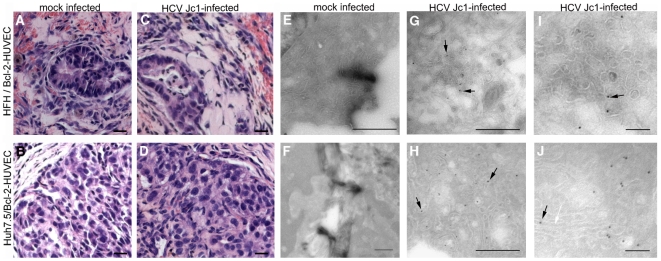
Histological and IEM analysis of HCV Jc1-infected HFH and Huh-7.5.Large numbers of epithelial-appearing cells were observed in Bcl-2-HUVEC gels harvested at 2 weeks post-engraftment and containing either mock-infected HFH or Huh-7.5 cells (A and B, respectively) or HCV Jc1-infected HFH or Huh-7.5 (C and D, respectively). Staining for HCV NS5A by IEM revealed minimal background stain in both mock-infected HFH and Huh-7.5 (E and F, respectively), in contrast to the presence of HCV NS5A protein immunogold stain associated with ER membranes observed in infected HFH and Huh-7.5 gels (G and H, respectively, black arrows). Panels I and J are higher magnifications of infected HFH and Huh-7.5 cells within the gels. White arrow in J indicates ER membrane. Size bars: 20 µm (A–D), 1 µm (E, F), 500 nm (G, H), and 100 nm (I, J).